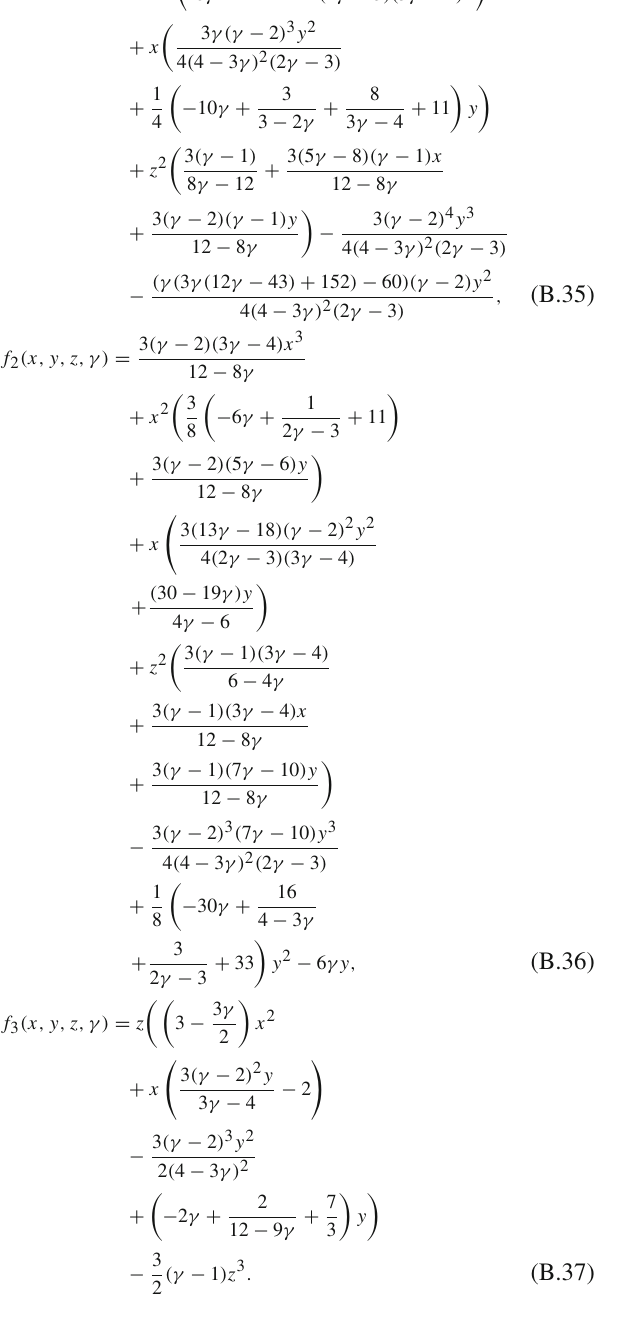
Table 3 Seven initial data sets for simulation of full system (46) and time-averaged system (78). All initial conditions are chosen in order to